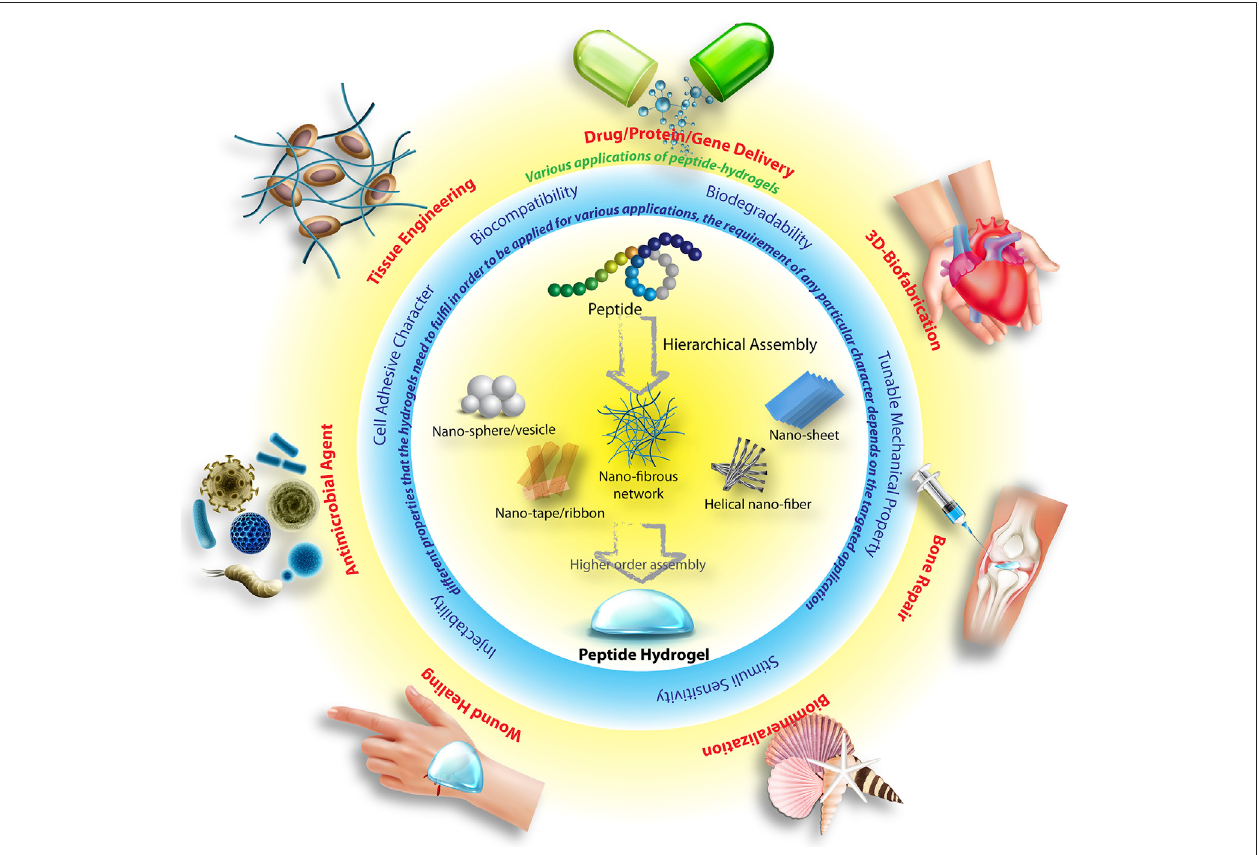
FIGURE 1 | Schematic illustration of the hierarchical peptide self-assembly to different nano-structures and eventually to hydrogel, various important parameters which are essential for these hydrogels in order to use for various therapeutic applications. Parts of the fi gure are taken from reference (Dasgupta and Das, 2019) with permission. Copyright 2019 American Chemical